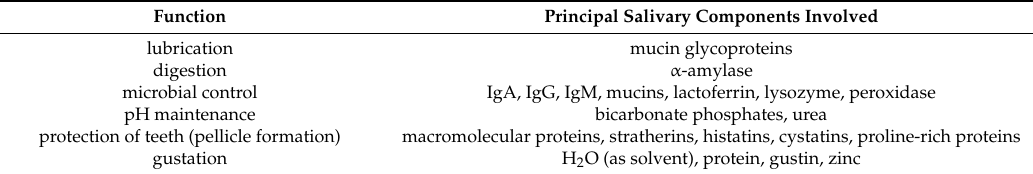
Table 1. Overview of the functions of saliva. Adapted from Humphrey and Williamson, 2001